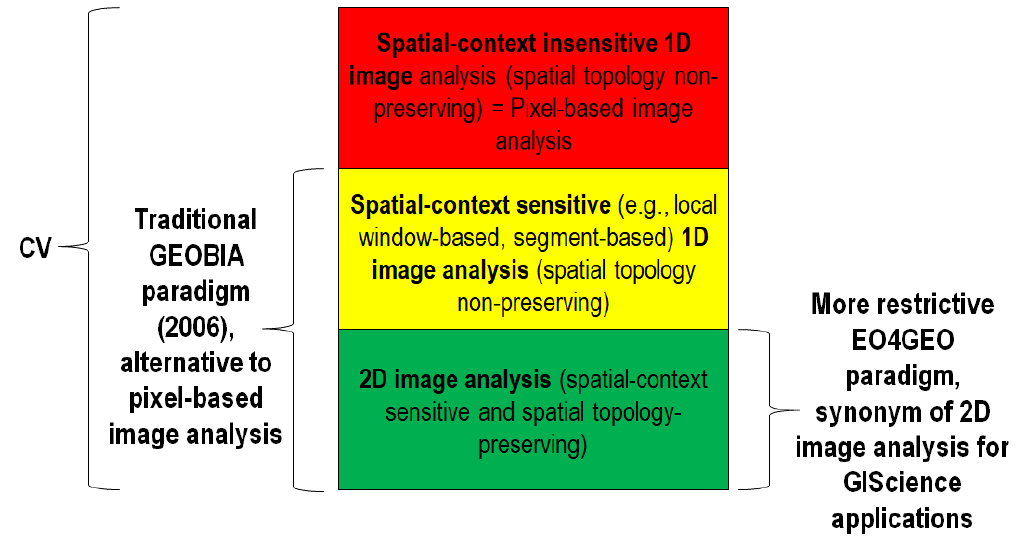
Figure 17. EO for Geographical Sciences (EO4GEO, EO4GIScience) framework, meaning EO big data analytics in operating mode for GIScience applications, constrained by 2D (retinotopic, spatial topology-preserving) image analysis in cognitive science [129]. EO4GEO is more restrictive than the traditional GEOBIA paradigm, formalized in 2006 and 2014 as a viable alternative to 1D spatial context-insensitive (pixel-based) image analysis [9,10,130].